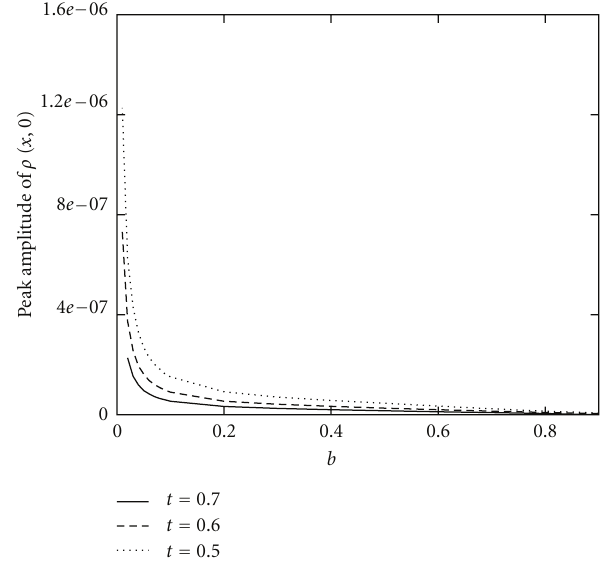
Figure 7: Magnetic field dependence of peak amplitude of charge ρ ( x ,0) calculated along the x -direction at di ff erent temperatures. Other relevant parameters are κ = 72, (cid:2) v = 0 . 1, and β sd =